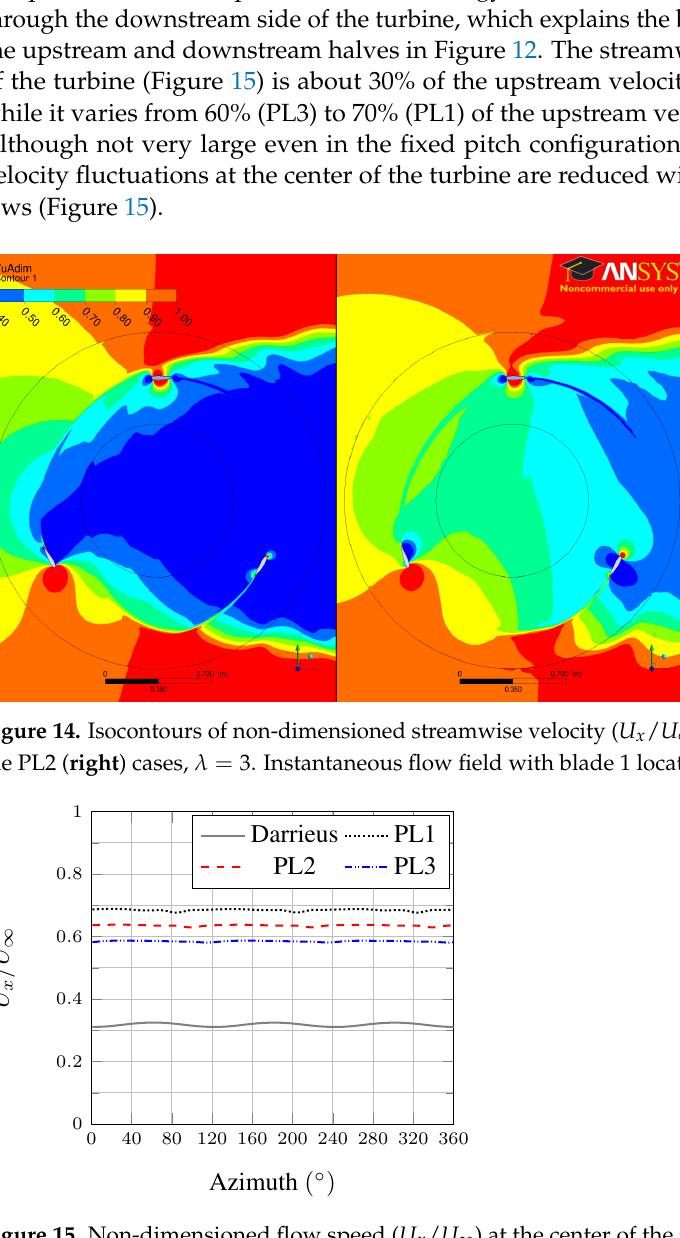
Figure 15. Non-dimensioned flow speed ( U x / U ∞ ) at the center of the turbine for the Darrieus and the pitching law cases, λ =